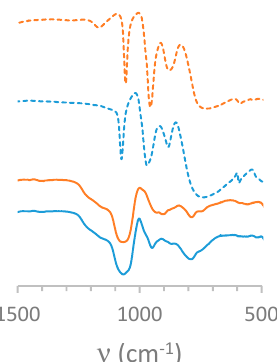
Figure 4. From up to down: Relevant IR vibration area for H 3 PMo 12 O 40 , H 3 PW 12 O 40 and difference spectra (SiO 2 @PMo-SiO 2 @NH 2 ) and (SiO 2 @PW-SiO 2 @NH 2 ).